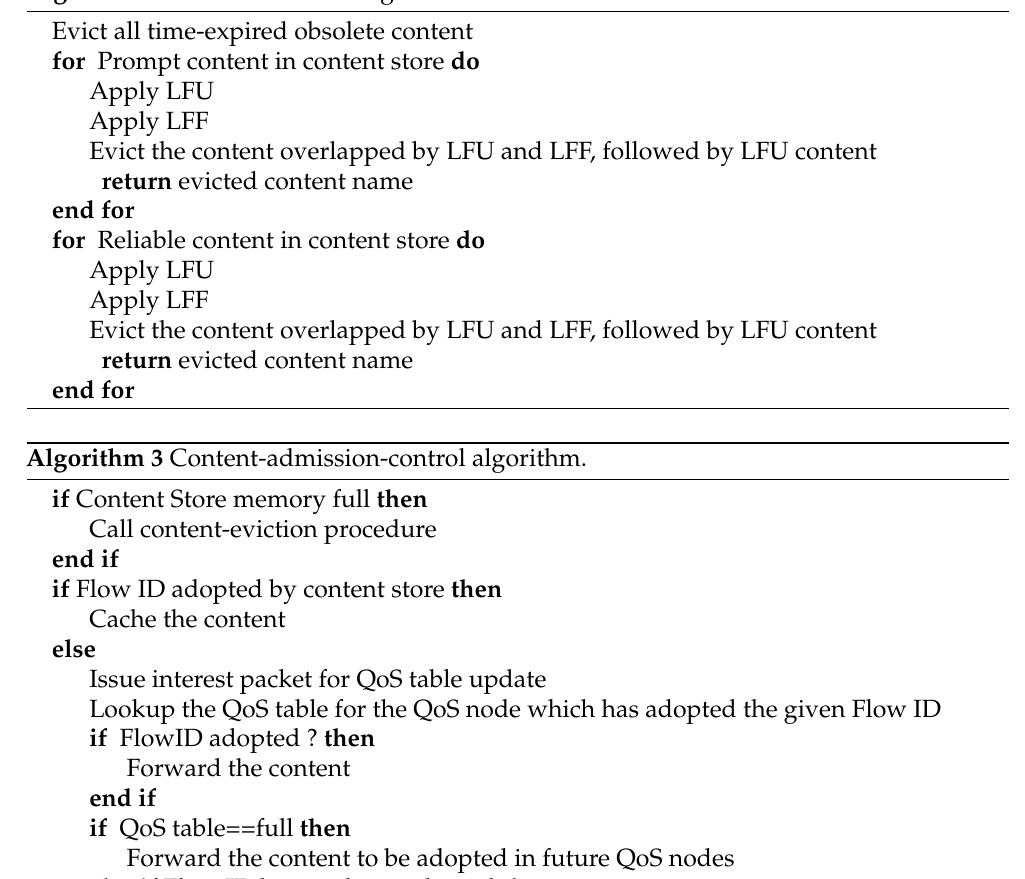
Algorithm 2 Content-eviction algorithm.